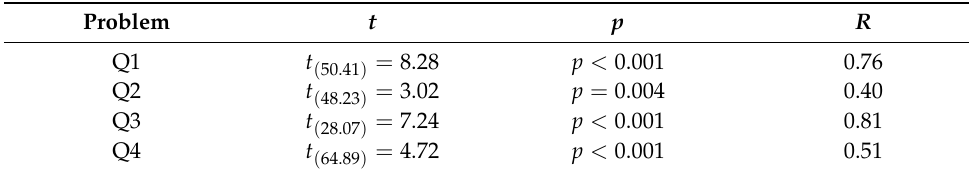
Table 11. The t -Student test results.